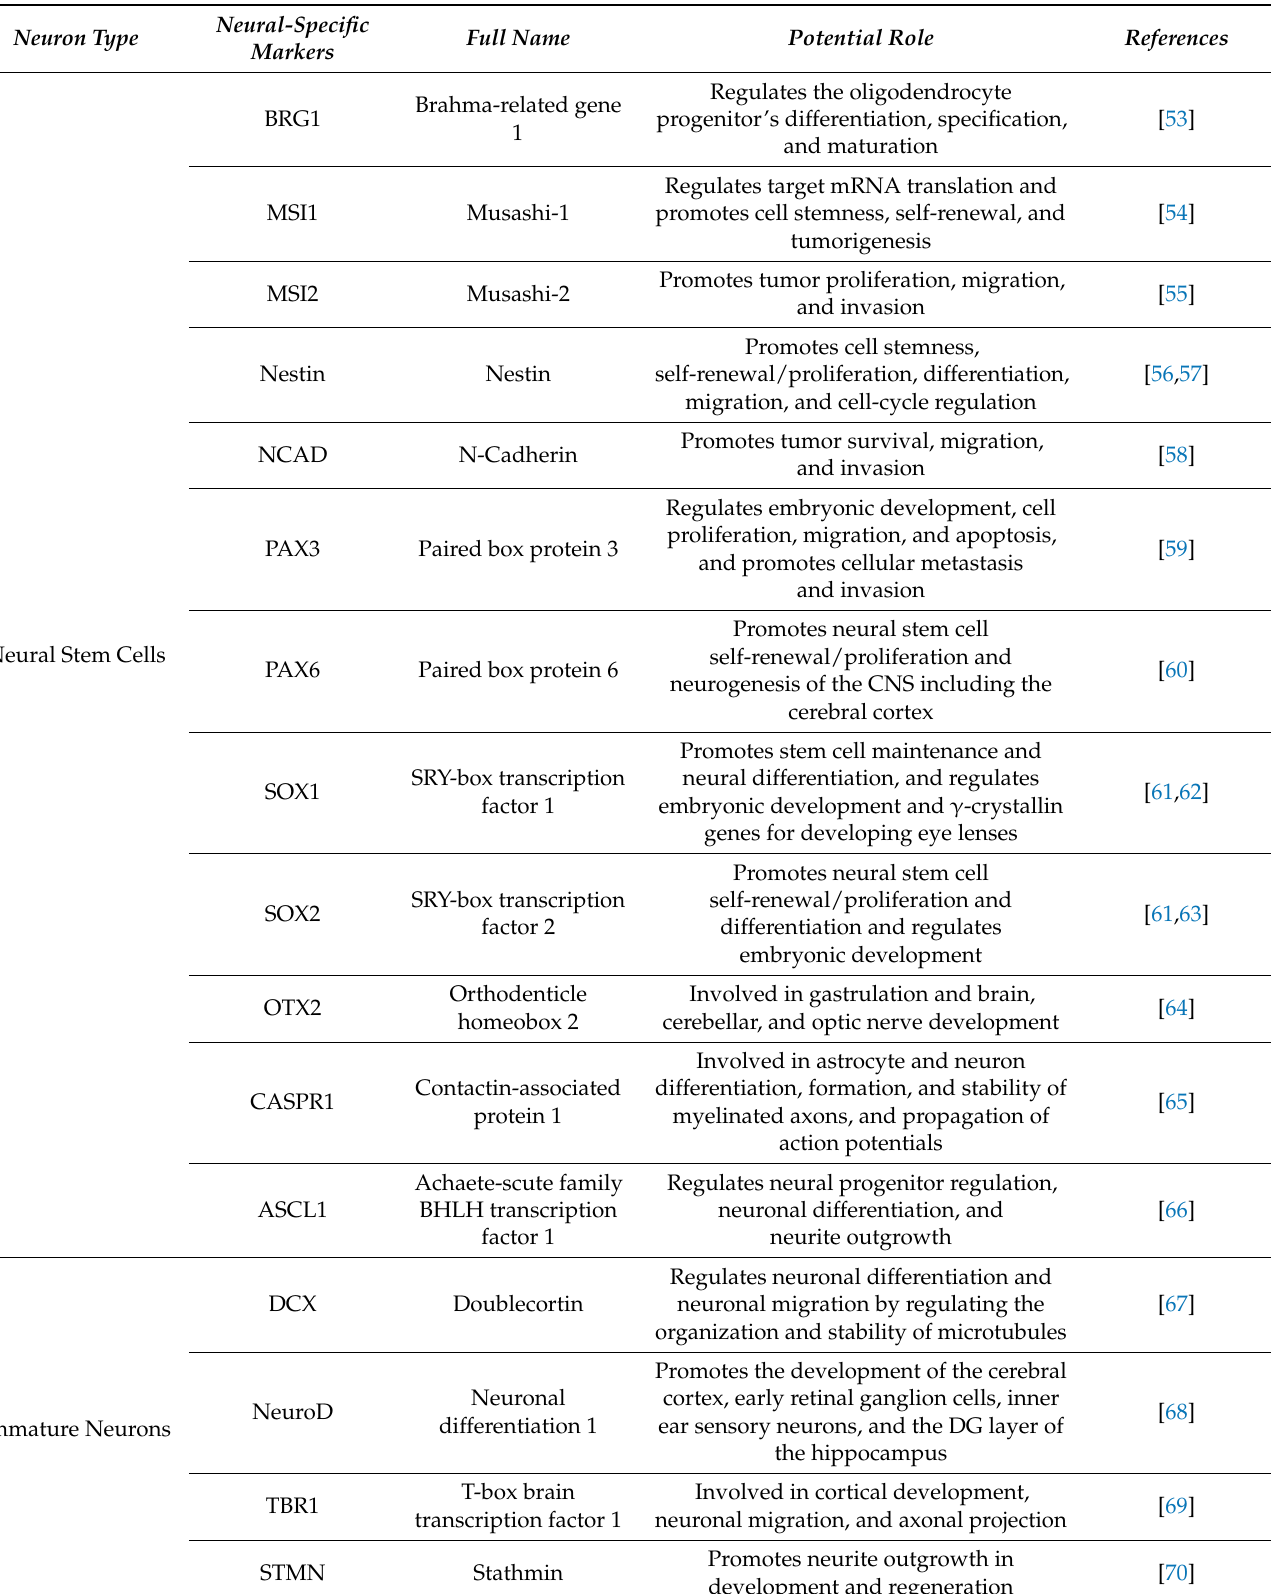
Table 5. List of neural-specific markers used in neuroscience